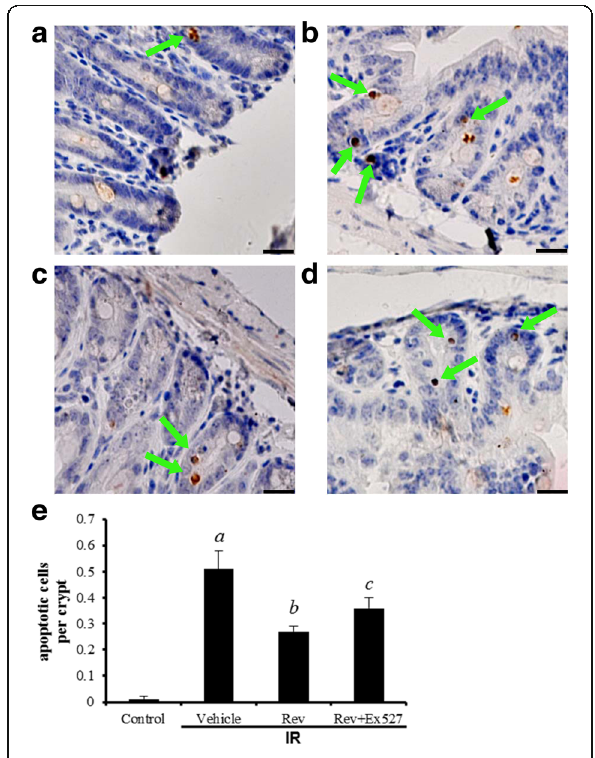
Fig. 3 Analysis of intestinal crypt cell apoptosis in irradiated mice. Photomicrograph of cleaved caspase-3 stained section of mouse intestine: ( a ) sham control, ( b ) vehicle-treated irradiation mice, ( c ) resveratrol treated irradiation mice, and ( d ) resveratrol plus Ex527 treated irradiation mice. Arrows indicate positive staining. e Bar graphs showing quantitative analysis of the apoptotic cells. The data are presented as means ± SE. n = 6 mice per group. a p < 0.01 vs control; b p < 0.05 vs IR; c p < 0.05 vs IR + Rev. Scale bar: 20 μ